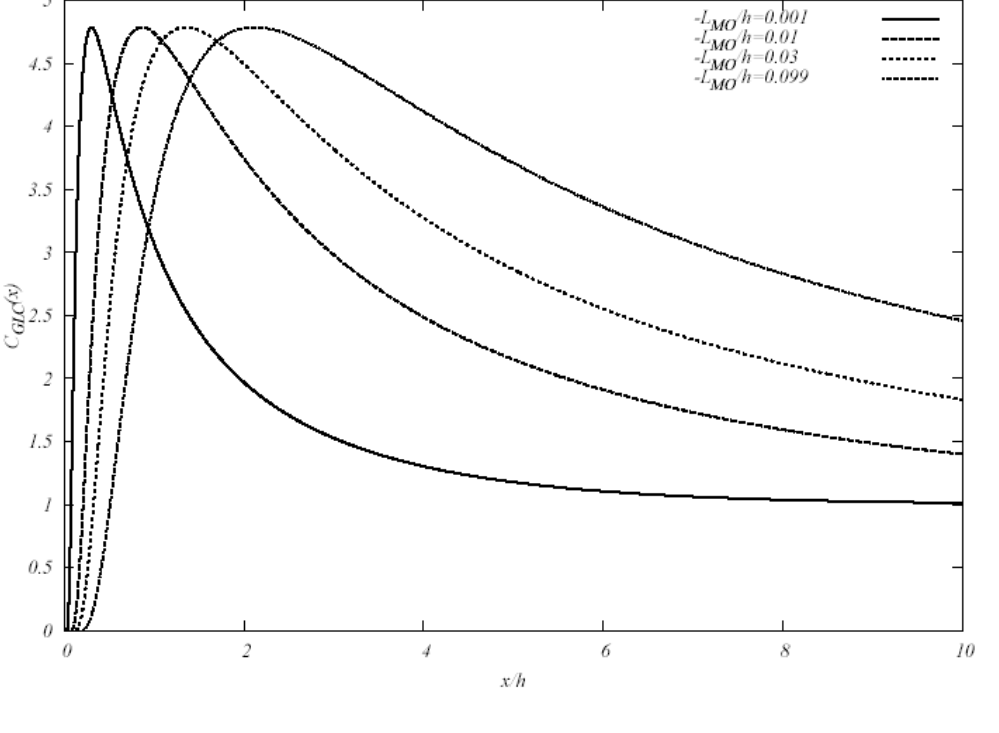
Figure 6. Ground level concentration versus the horizontal distance from the source. The 1.0/~ source height has been set to . The value of the maximum GLC does not  hhh ss change as the turbulence